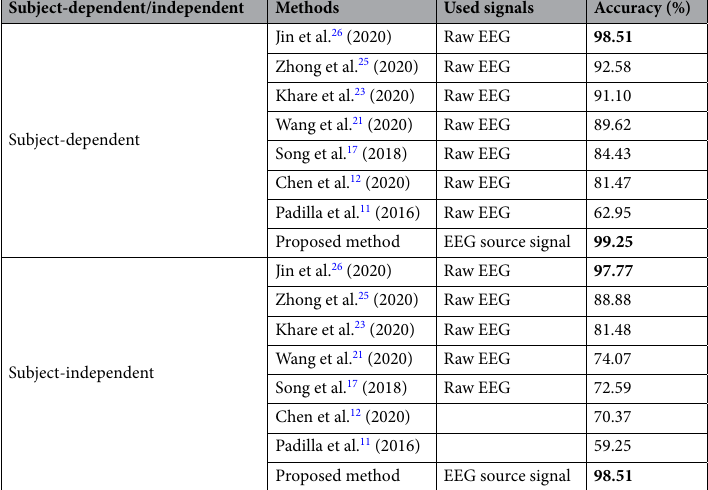
Table 3. Classification accuracy and details of the proposed method and deep neural network approaches which used raw EEG signals 11,12,17,21,23,25,26 for the SEED dataset. Significant values are in bold.